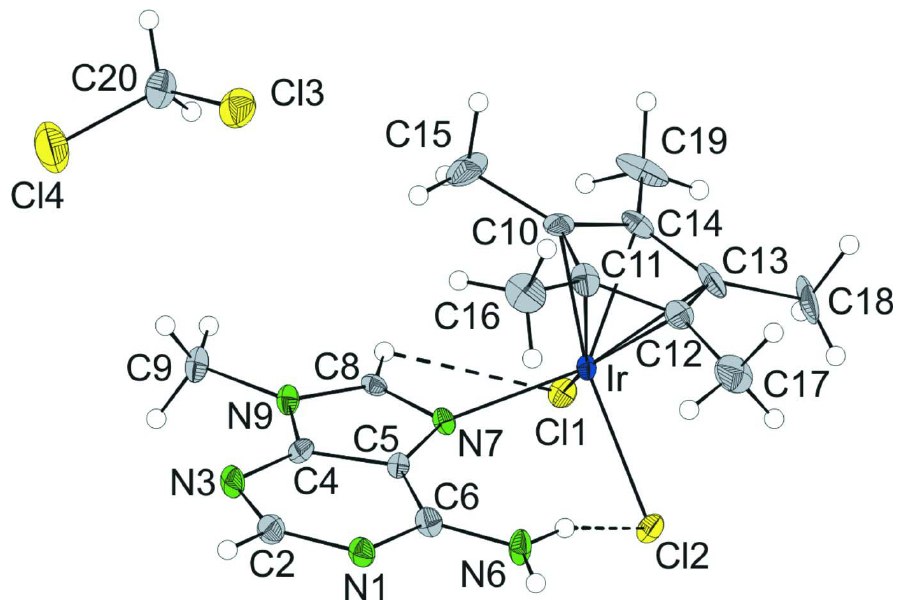
Figure 1 Structure of the asymmetric unit of the title complex [IrCl are drawn at the 30% probability level and H atoms are shown as small spheres of arbitrary radii.